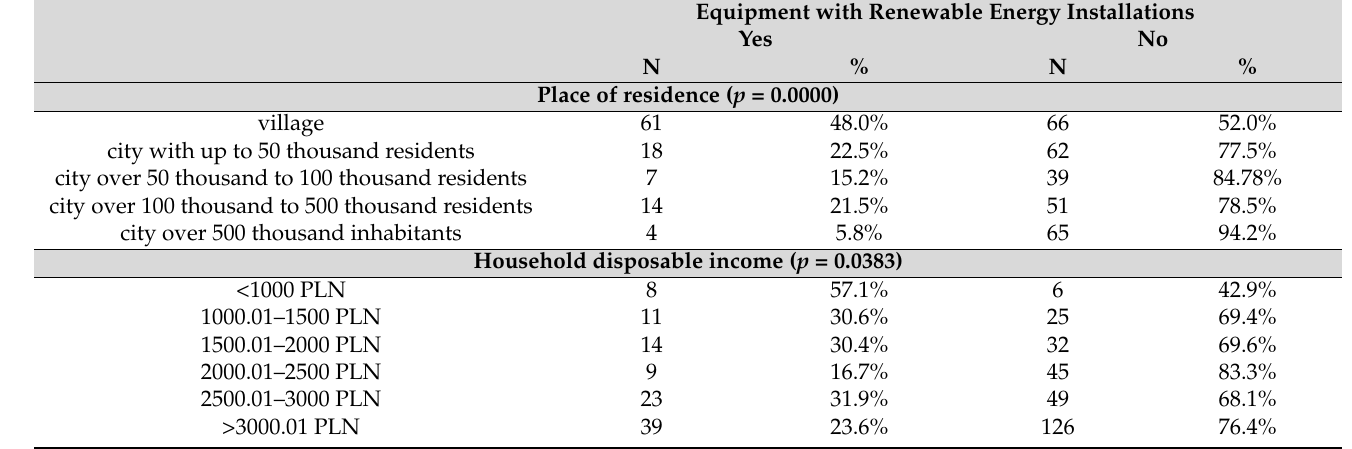
Table 3. Household equipment with renewable energy installations for statistically significant criteria. Results of chi-square independence